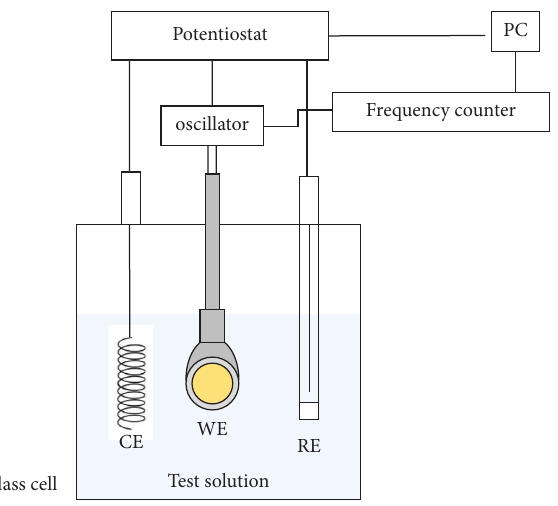
Figure 1: Experimental apparatus for the EQCM measurements used in this